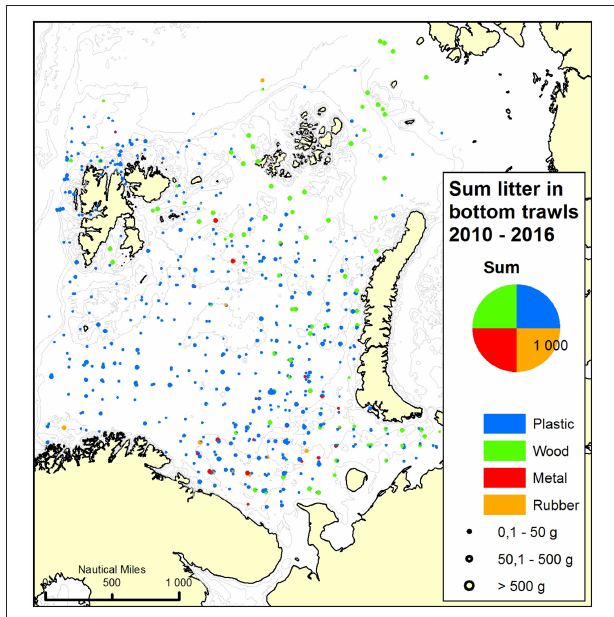
FIGURE 5 | Marine litter from bottom trawl from 2010 to 2016. Observations of plastics (blue), wood (green), metal (red) and rubber (orange).